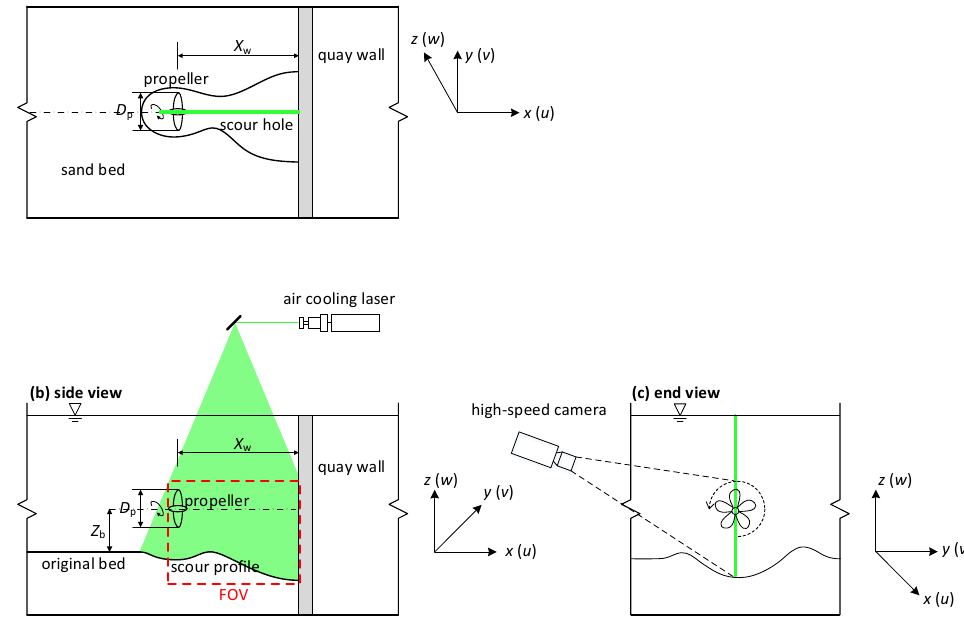
Figure 1. Experimental setup of PIV system, ( a ) top view; ( b ) side view; ( c ) end view, where FOV = field of view.